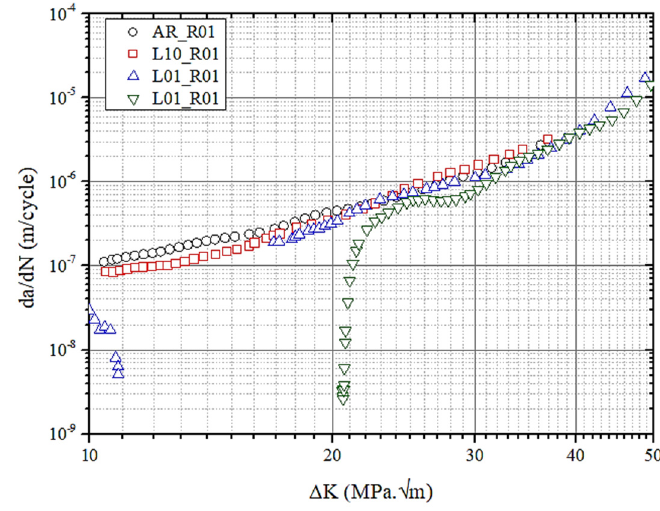
∆ K plots for R = 0.1.